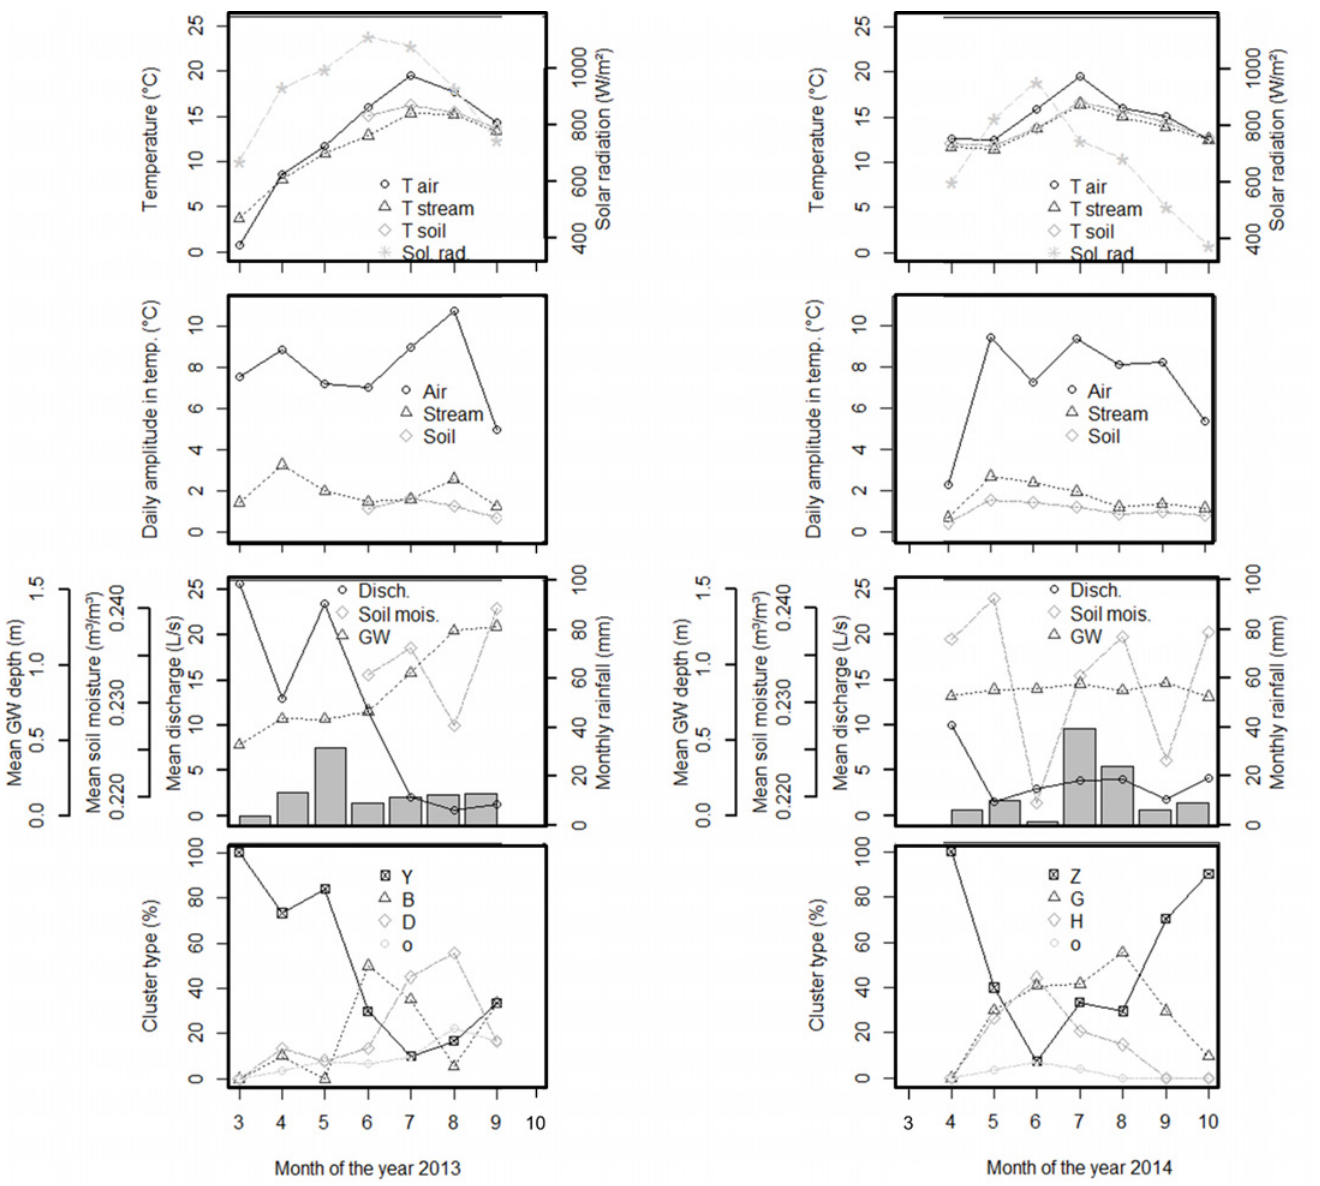
Fig 2. Time-series (monthly aggregation) of the hydrological and meteorological variables, showing the difference between 2013 and 2014. The last panels in each column represent the relative occurrence of each cluster ( “ o ” being the outliers).